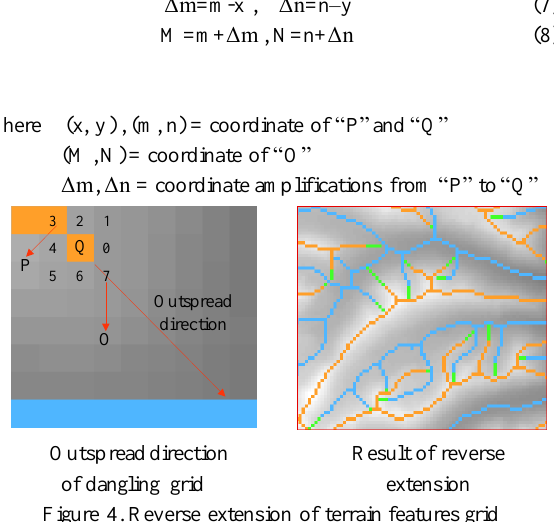
Figure 4. Reverse extension of terrain features